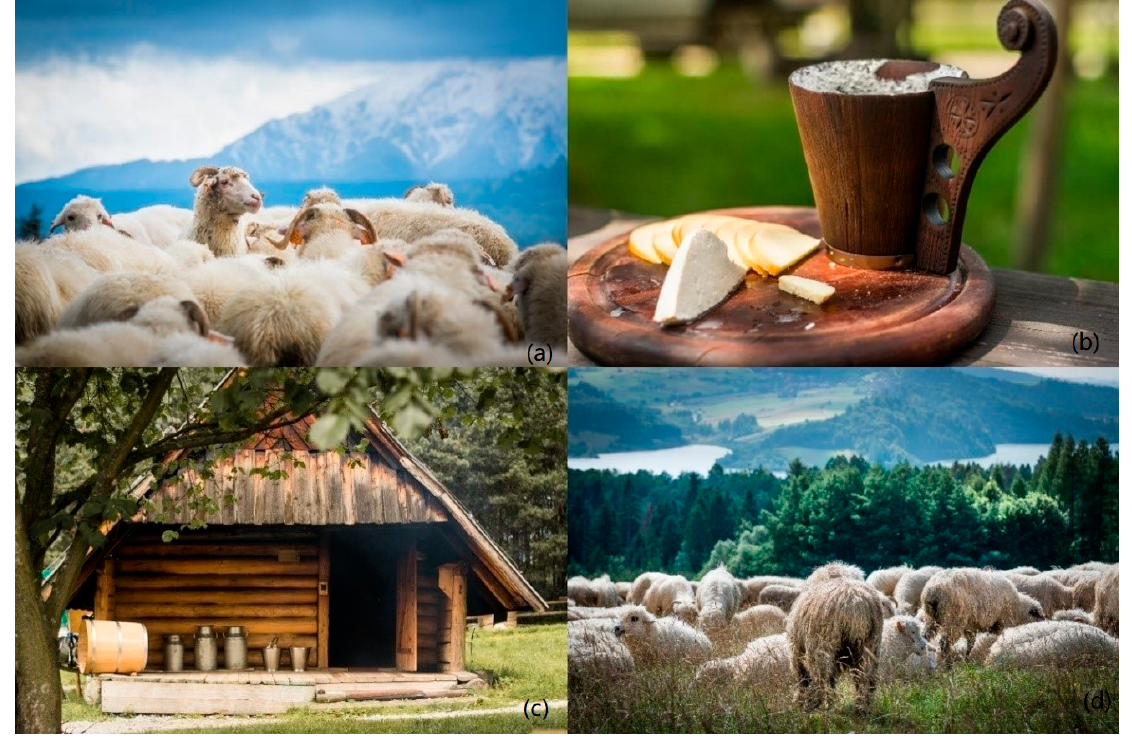
Figure 4. Cultural grazing of mountain sheep in the Polish Carpathians: ( a ) large-scale grazing of native mountain breeds of sheep, ( b ) traditional products made of Polish mountain sheep milk, ( c ) shepherd’s hut, ( d ) large-scale grazing of native mountain breeds of sheep (Photography. M. Pasternak).